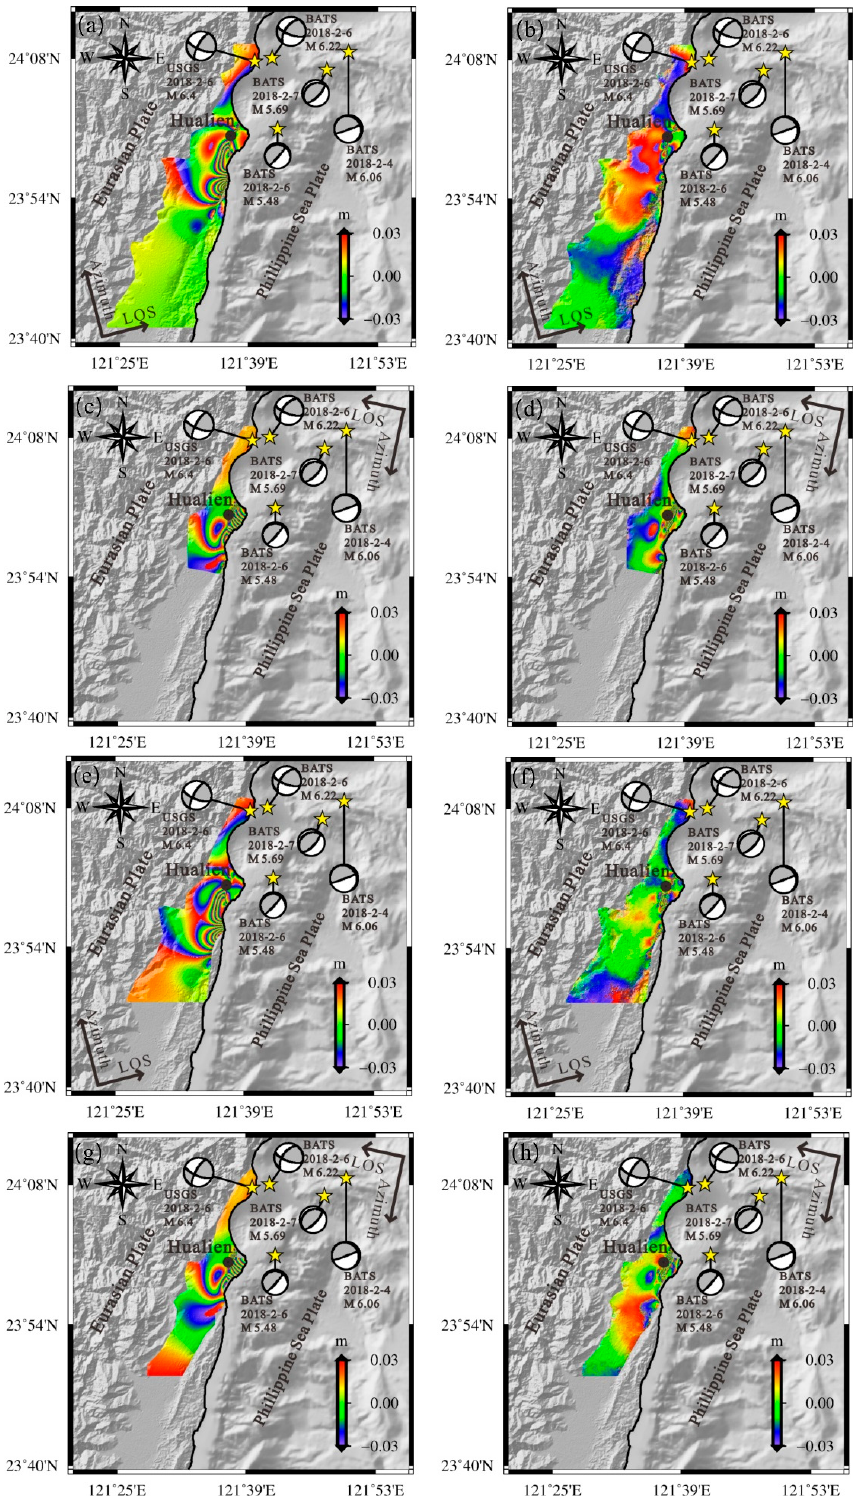
Figure 6. The predicted InSAR deformation using the faulting model shown in Figure 4b, and the residual between the observed (Figure 2) and predicted InSAR data. The predicted ALOS-2 ascending ( a ), ALOS-2 descending ( c ), Sentinel-1 ascending ( e ), and Sentinel-1 descending ( d ) InSAR deformation fields based on the preferred faulting model shown in Figure 4b. The residuals between the observed and predicted InSAR data of the ALOS-2 ascending ( b ), ALOS-2 descending ( d ), Sentinel-1 ascending ( f ), and Sentinel-1 descending ( h